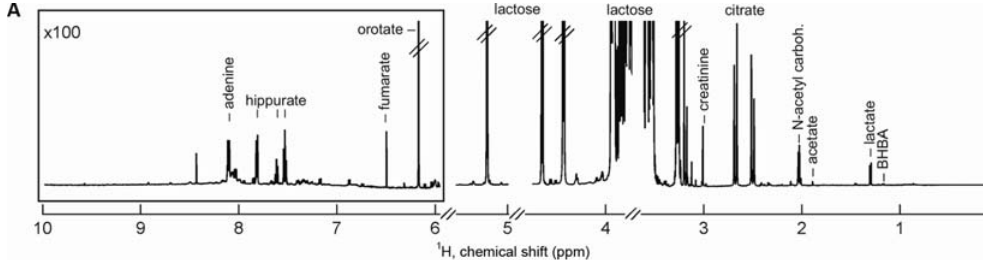
Figure 1. ( A ) 1 H NMR spectrum of cow milk ultrafiltrate [Adapted from 37]. ( B ) 13 C NMR spectrum of cow milk [Adapted from 39]. ( C ) 31 P NMR spectrum of cow milk ultrafiltrate [Adapted from 40]. ( D ) 1 H- 13 C HSQC NMR spectrum of cow milk [Adapted from 41]. Reprinted with permission